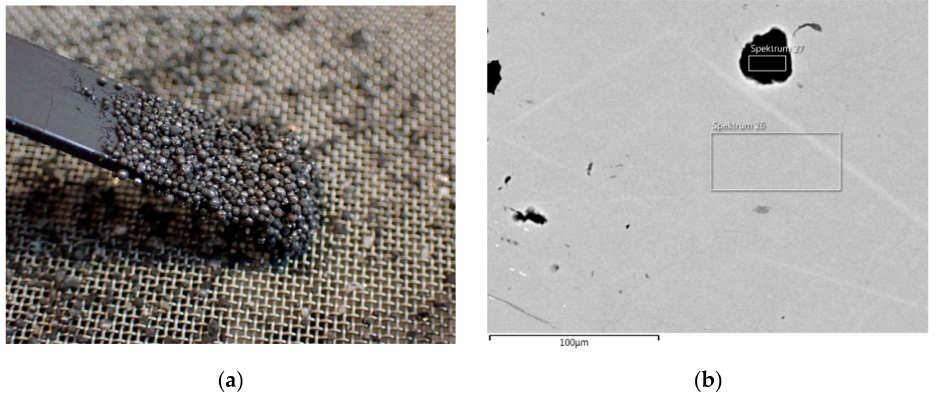
Figure 4. ( a ) Accumulation of metal spheres on a magnetic tape during sampling of NMC622. ( b ) SEM image of the metal surface of NMC622 under 500-fold zoom, with “Spektrum 27” and “Spektrum 28” being elemental analysis